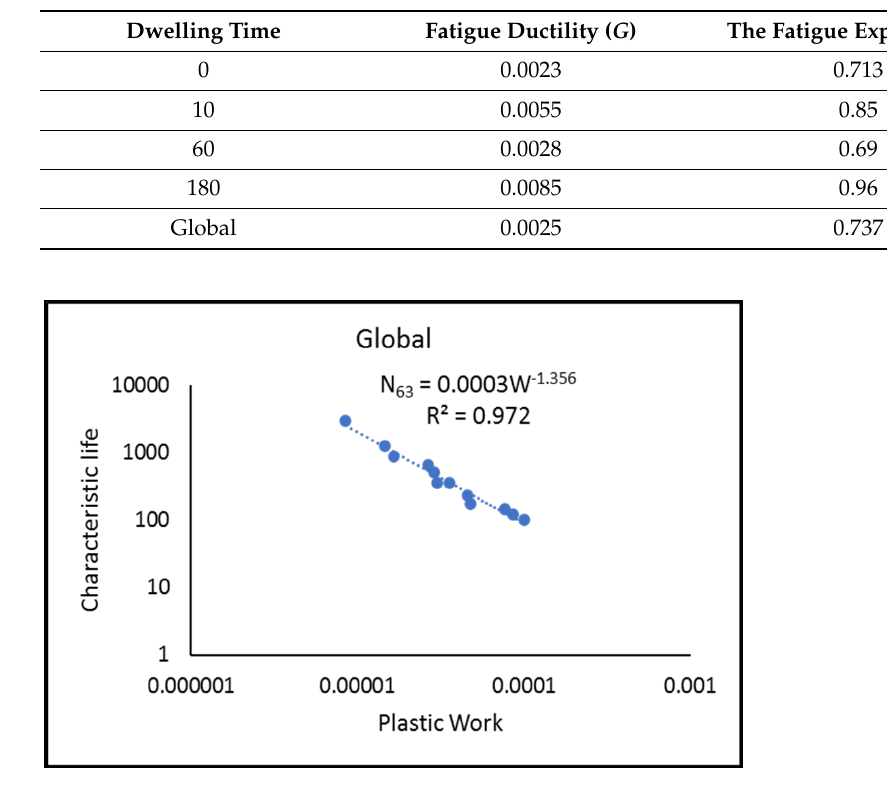
Figure 33. Characteristic life (global Morrow Energy equation) vs. plastic work for SAC305 joints at various dwelling times on a log–log scale.